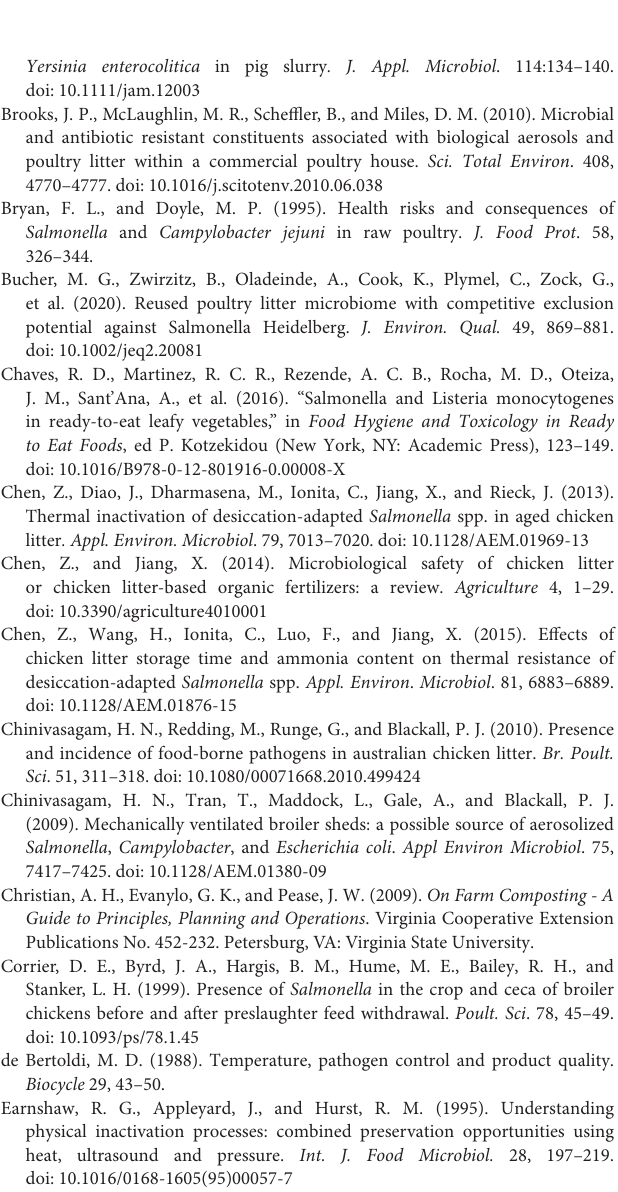
Supplementary Figure 1 | Electrical conductivity (EC) dynamics during incubation of broiler litter (BL) at different temperatures (30, 40, 50, and 60 ◦ C), water content (40, 55, and 70%) and initial pH (6, 7, and 8.5). The different incubation temperatures were applied during phase I (weeks 1–2), while at phase II (weeks 3–4) the incubation temperature was 30 ◦ C. Error bars represent the standard deviations of triplicate vessels. Letters denote significant